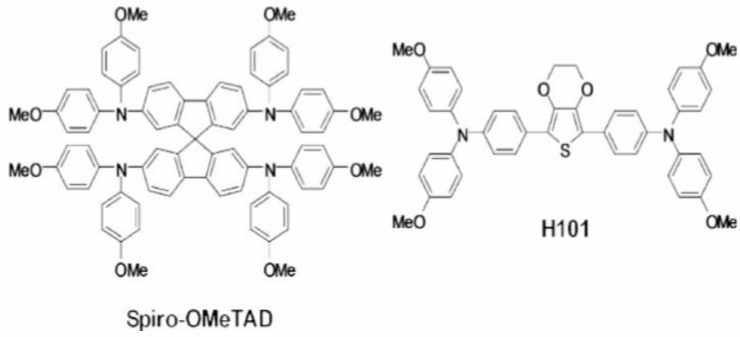
Figure 2. Spiro-OMeTAD and H101 structure comparison; H101 being easier to synthesise. (from Li et al.